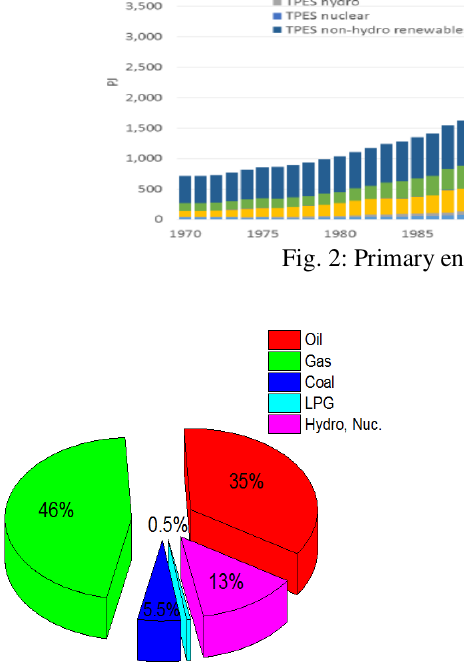
Fig. 3: The contribution of different fuels in electricity production [13].